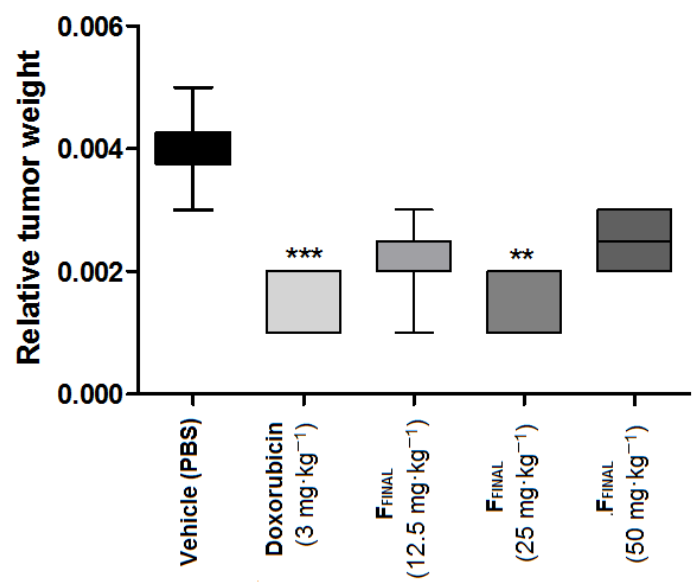
Figure 5. Relative weight, of Ehrlich solid tumor on the flank—F FINAL fraction. Results expressed as mean ± standard deviation; Female Balb / c mice ( n = 8 / group); Treatments (orally every day): vehicle (PBS pH 7.0 + Tween 80, 10 mL · kg − 1 ), F FINAL (12.5, 25 and 50 mg · kg − 1 ); Treatments (i.p. every three days): Doxorubicin (3 mg·kg − 1 ). Statistical analysis by Kruskal – Wallis test followed by Dunn ’ s